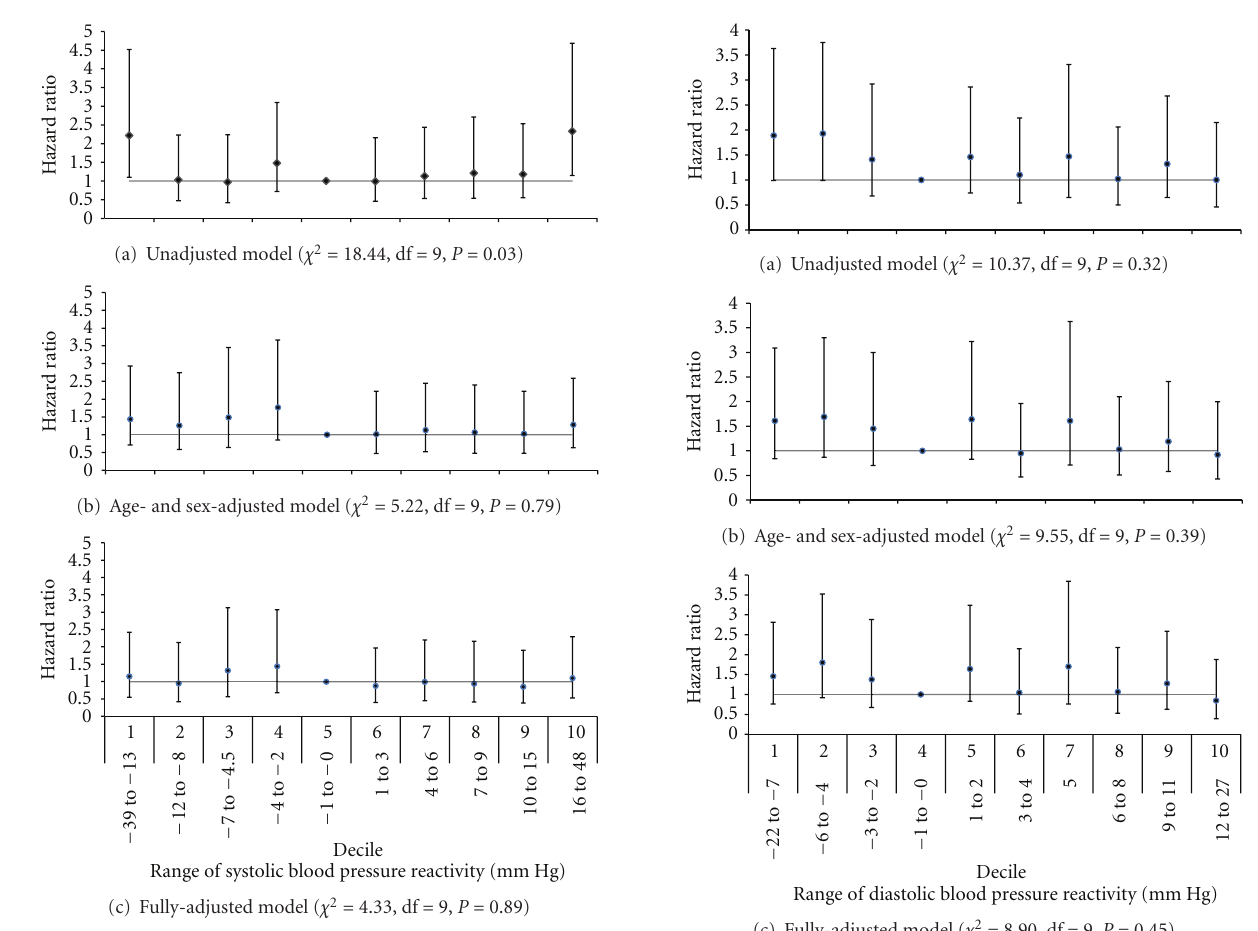
Figure 1: Hazard ratio with 95% confidence intervals of incident cardiovascular disease events by decile of systolic blood pressure reactivity in (a) an unadjusted model, (b) age- and sex-adjusted model, and (c) model additionally adjusted for body mass index, Framingham risk score, and high school education.